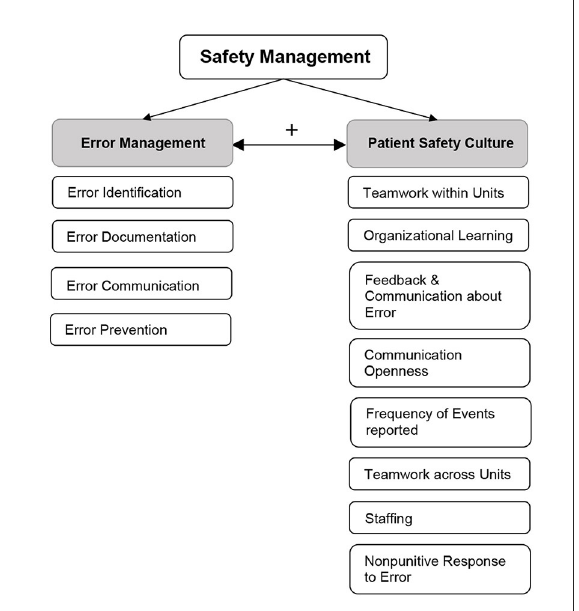
FIGURE1 Theoretical framework of Safety Management operationalized by the concepts of EM and